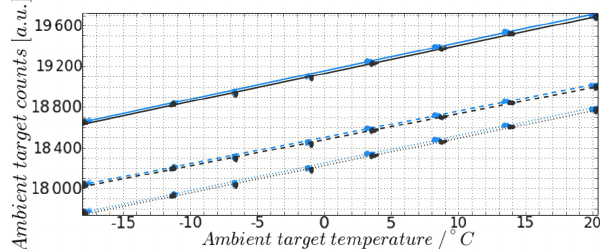
Figure 5. Ambient target temperature vs. the measured signal (counts) of the two ambient targets for all three standard frequency channels of the HALO MTP (different line styles). Different line colors correspond to the measurement of the two individual ambi- ent